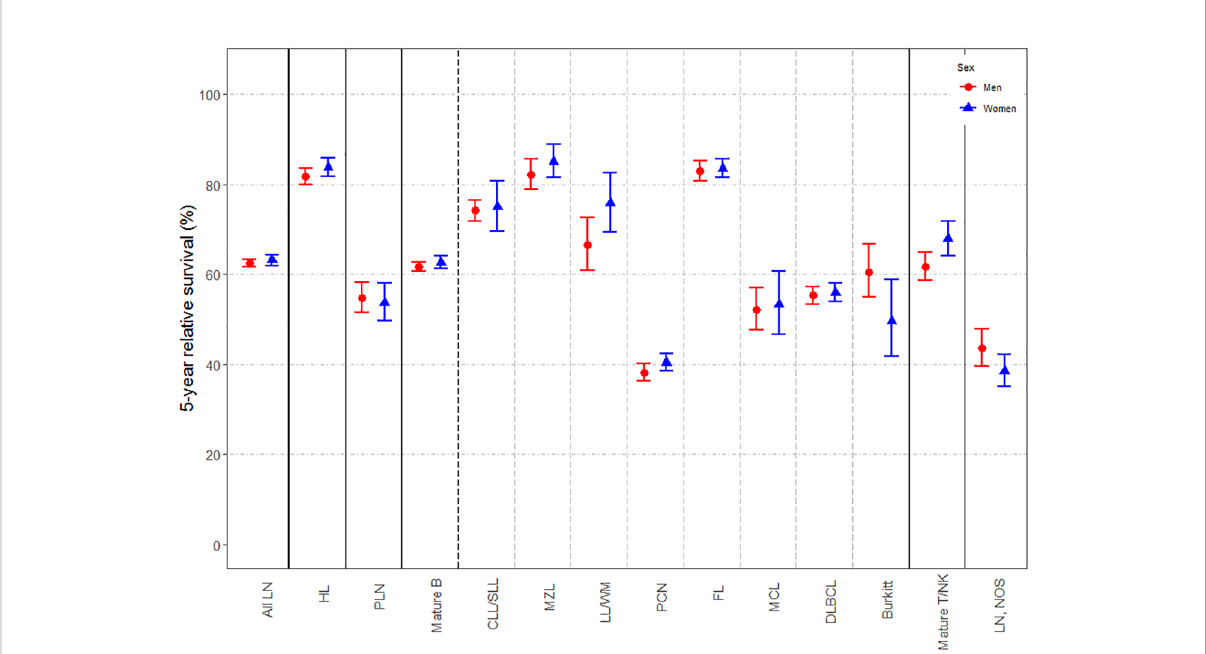
FIGURE 1 Estimates of 5-year net survival for patients with lymphoid neoplasms diagnosed in 2002-2013, in Spain, according to sex. LN, Lymphoid neoplasm; HL, Hodgkin lymphoma; PLN, precursor lymphoid neoplasms; mature B, mature B-cell neoplasms; CLL/SLL, chronic lymphocytic leukemia/small lymphocytic lymphoma; MZL, marginal zone lymphoma; LL/WM, lymphoplasmacytic lymphoma/Waldenström ’ s macroglobulinemia; PCN, plasma cell neoplasms; FL, follicular lymphoma; MCL, mantle cell lymphoma; DLBCL, diffuse large B-cell lymphoma; Burkitt, Burkitt lymphoma/leukemia; Mature T/NK, mature T-cell and NK-cell neoplasms; NOS, not otherwise speci fi